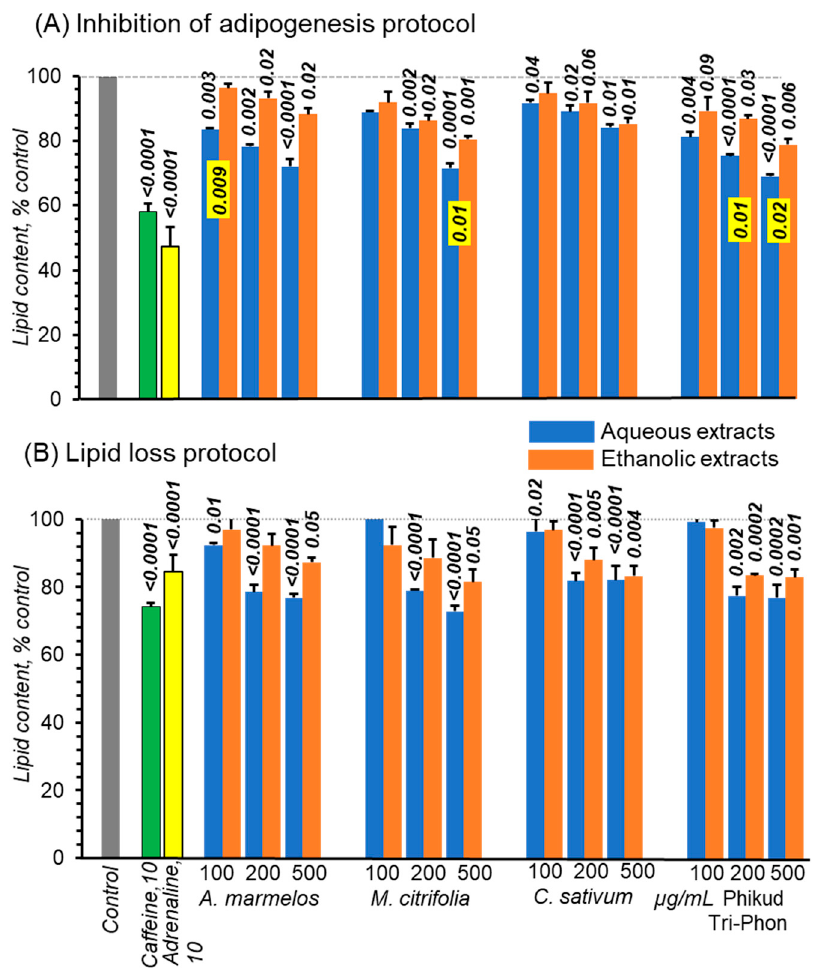
Figure 3. Lipid accumulation in 3T3-L1 cells after 7 days of adipogenesis. In ( A ), the cells were also treated with, either one of four aqueous extracts at 100–500 ug/mL of extract indicated (Blue bars) or ethanolic extracts from the same preparations (Orange bars). For ( B ), the protocol was identical except the same series of extracts were only present for day 7 and that represents loss of accumulated triglycerides. All concentrations are µg/mL, error bars are means ± SD, n = 3 and p -values comparing control by one-way ANOVA, p -values in yellow boxes compare differences between aqueous and ethanolic extracts by 2-tailed Student’s t -test.